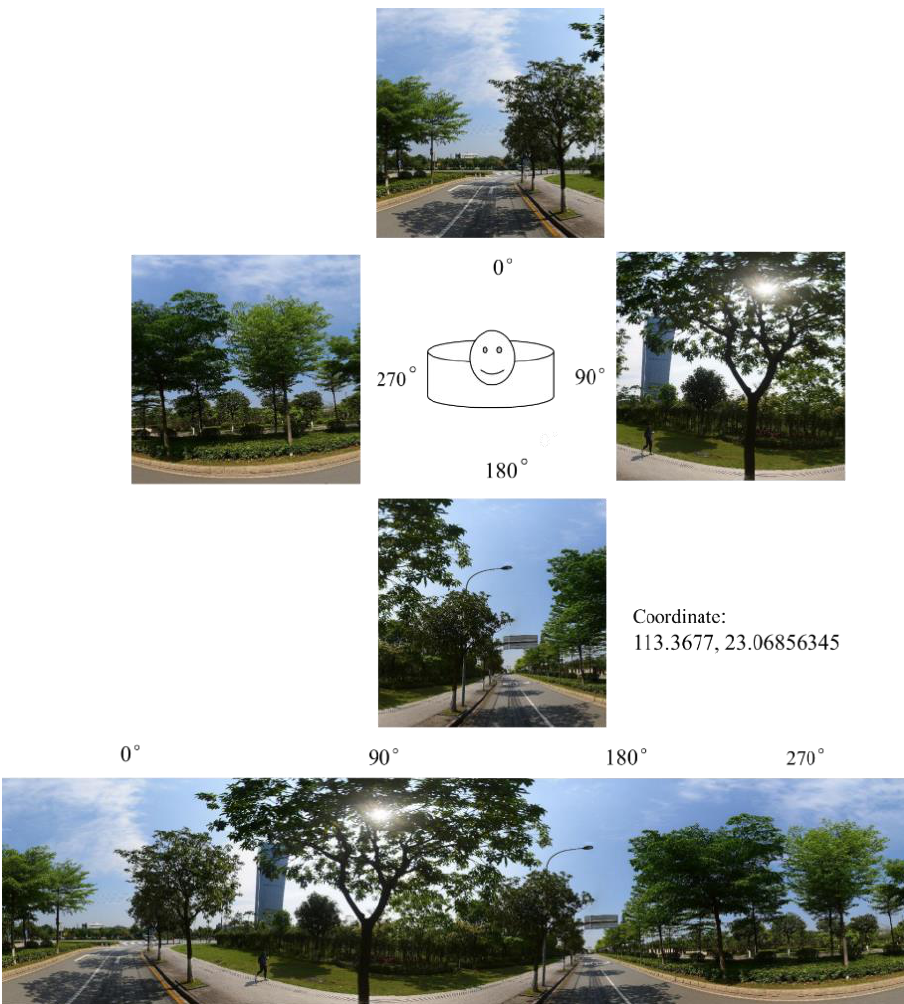
Figure 2. Street-view greenery images capturing an example area.